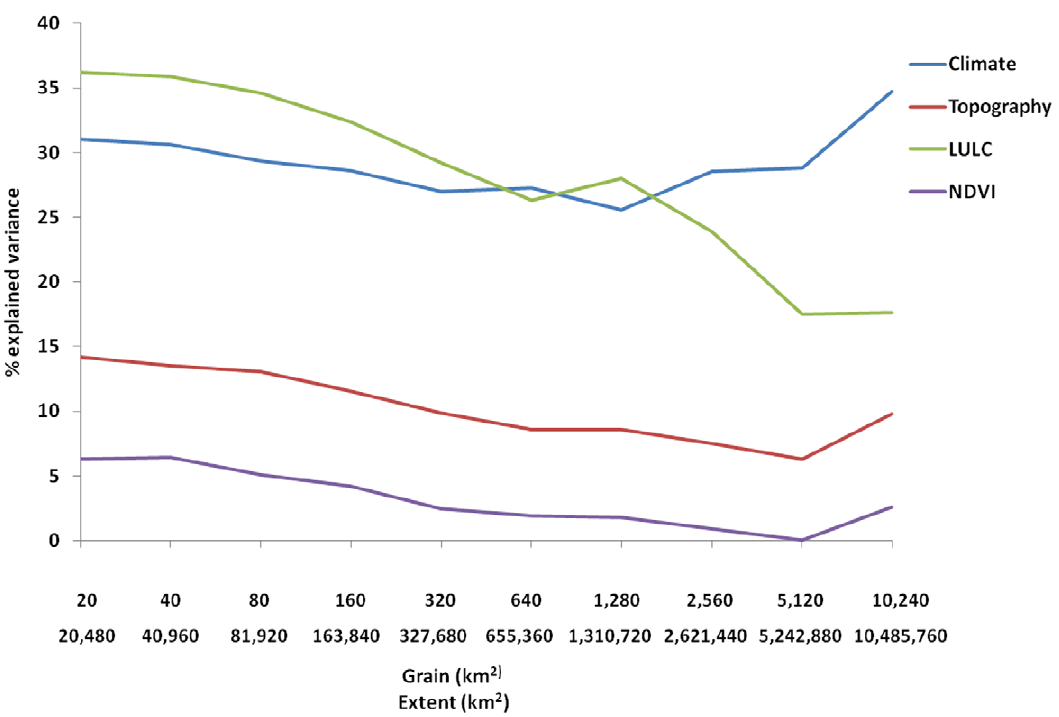
Figure 1. Explained variance rates of environmental variable groups in mammal species composition at varying spatial scales in the contiguous USA (demonstrated using CCA analyses). Scale consists of grain size (upper number on the x-axis) and extent (lower number on the x-axis). Explained variances represent the pure effect of each variable group used in the analyses (see Table 1 for details on the different variable groups).